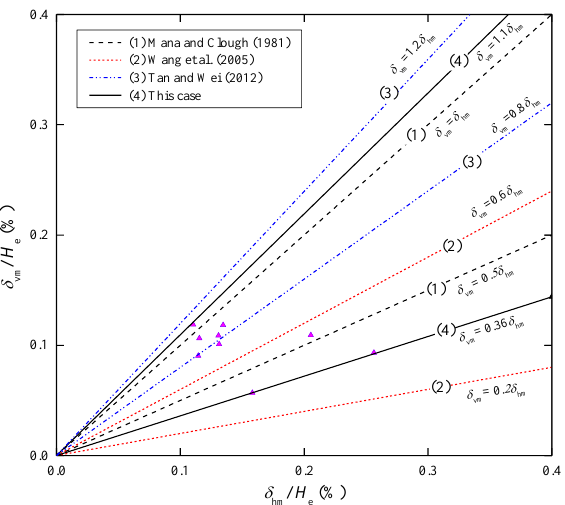
Figure 14. Normalized maximum wall deflections versus normalized maximum ground settle- ments.